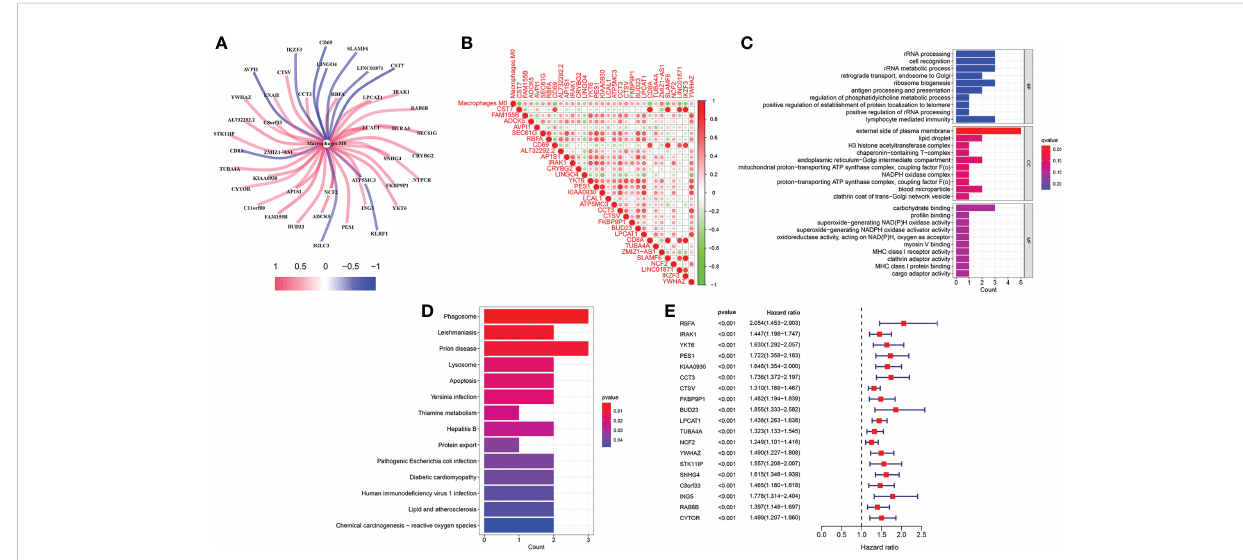
FIGURE 3 Identi fi cation of M0-related genes. (A) Correlations between MRGs and macrophages M0. (B) Correlations within the 31 MRGs. (C) GO functional enrichment analysis of the MRGs. (D) KEGG functional enrichment analysis of the MRGs. (E) Univariate Cox regression analysis of the